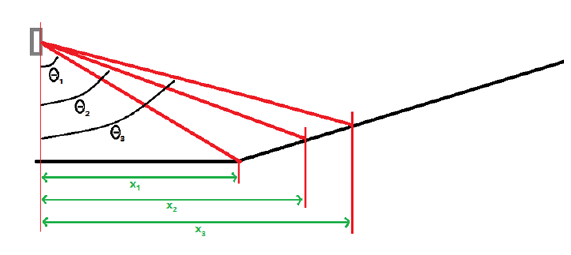
Figure 2. Mobile App Screens.